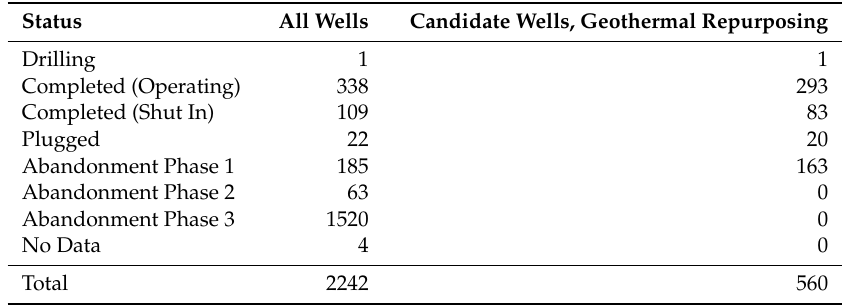
Table 2. Status of UK onshore hydrocarbon